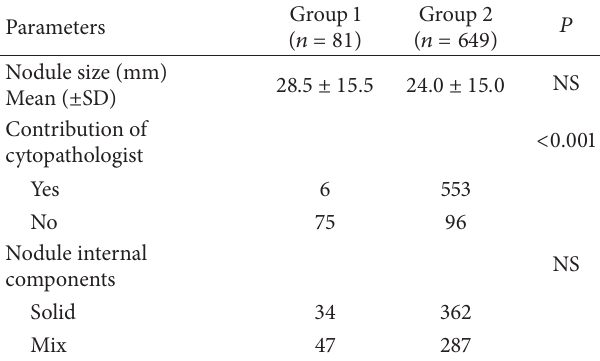
Table 2: Comparison of study groups.